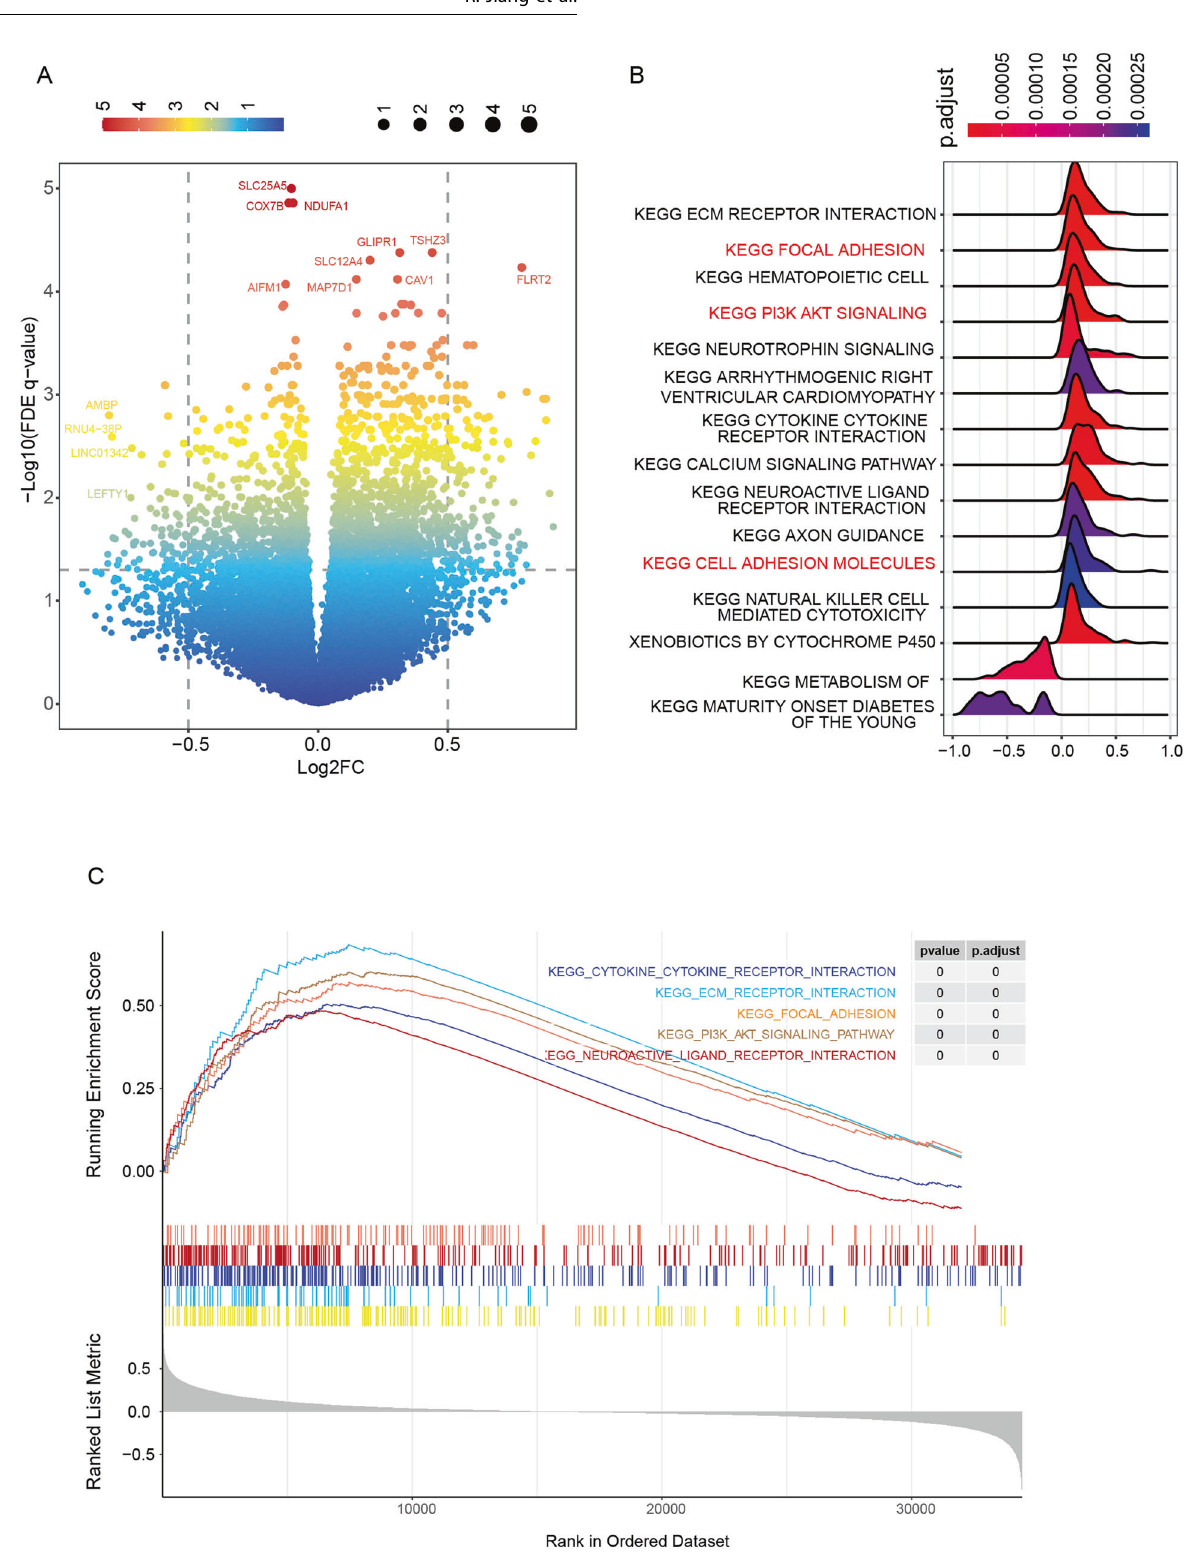
Fig. 4 Higher CRGs score was related to abnormal cell adhesion via the Akt-PI3K pathway. A Differentially expressed genes (DEGs) between the high-CRGs score group and the low-CRGs score group. B KEGG enrichment analyses of DEGs between high-CRGs score group and low-CRGs score group. C GSEA enrichment analyses of DEGs between high-CRGs score group and low-CRGs score group.